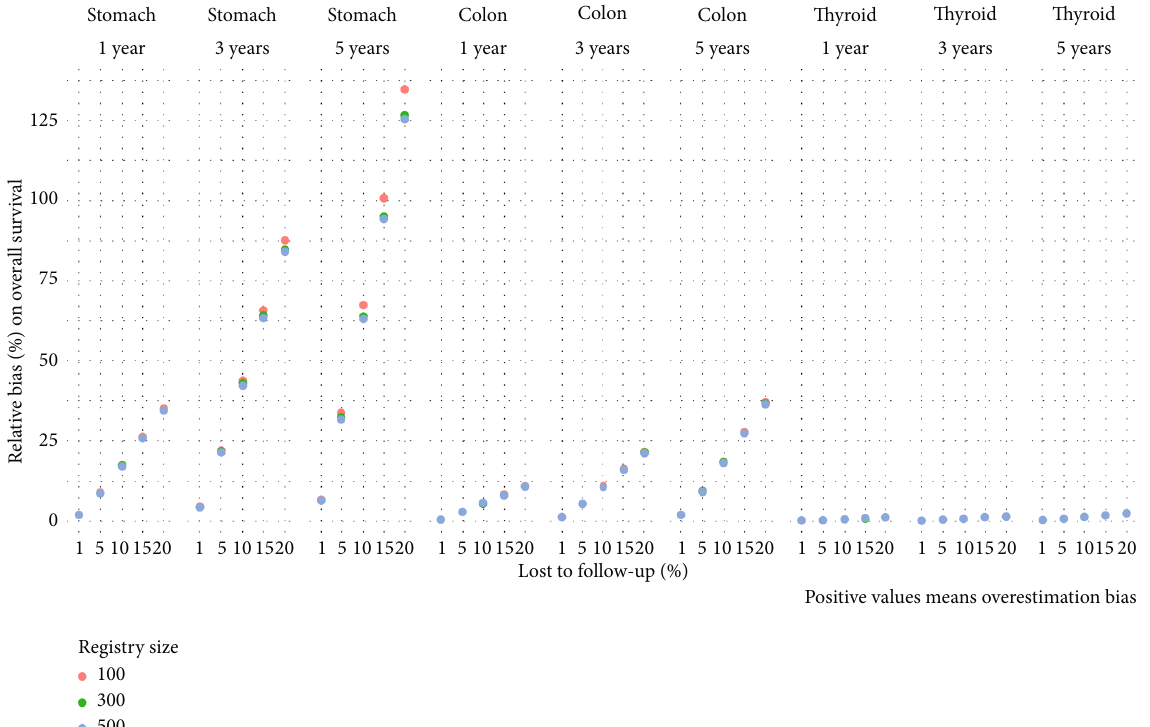
Figure 2: Relative bias (%) on overall survival due to censoring lost to follow-up cases by cancer localization, follow-up time, percentage lost to follow-up, and registry size.